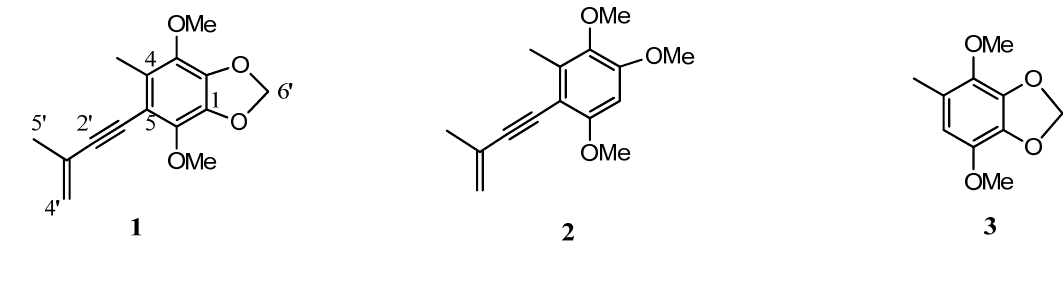
Figure 1. Structures of 1 – 3 from the fruiting bodies of A . camphorate